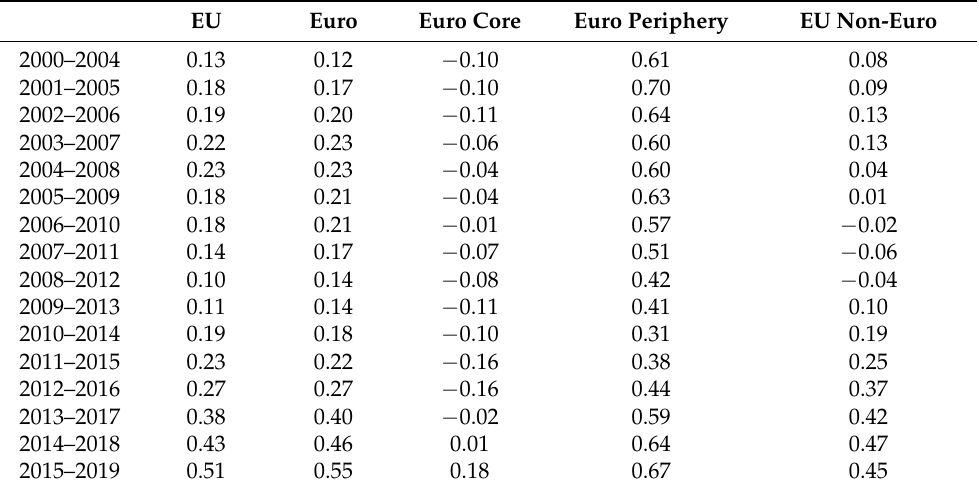
Table 8. Core inflation rate—averages of country-level correlation coefficients for different country groups.